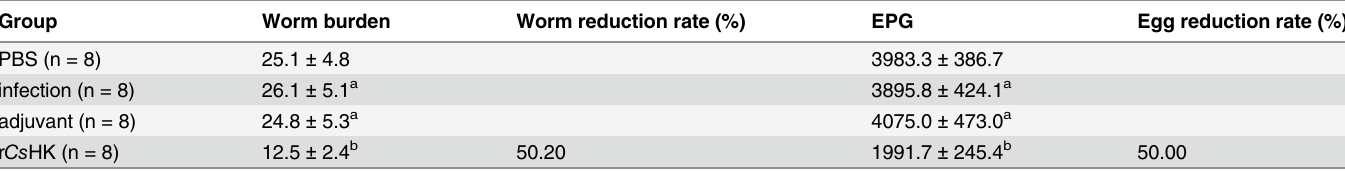
Table 2. Worm burden and EPG of rats in different